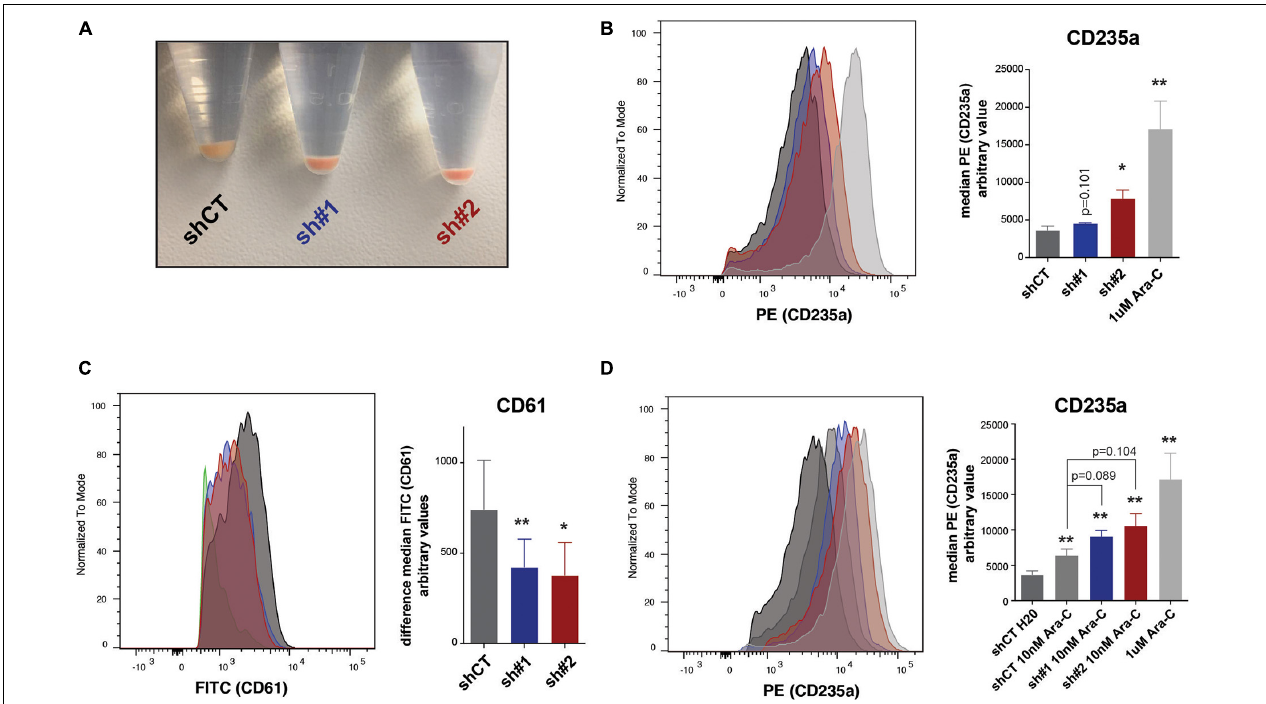
FIGURE 5 | (A) Picture of pelleted K562 infected with an empty short hairpin RNA (shRNA, shCT ) and two shRNAs against PHF19 ( sh #1 and sh#2 ) 5 days after puromycin selection. (B) CD235a marker levels measured by flow cytometry in shCT-, sh# 1-, sh#2-infected cells 4 days after puromycin selection and 1 µ M of Ara-C treatment in uninfected cells as a positive control. Left , representative plot of a single experiment. Right , bar plot of the mean of median cytometry values (shCt and sh#1, n = 4; sh#1 and 1 µ M of Ara-C, n = 3) + SEM. (C) CD61 marker levels measured by flow cytometry in shCT-, sh# 1-, and sh#2-infected cells 4 days after puromycin selection and treated with 1 nM phorbol myristate acetate (PMA) for 24 h. Left , representative plot of a single experiment. Right , bar plot of the mean of median cytometry values ( n = 3) + SEM. (D) CD235a marker levels measured by flow cytometry at 4 days in shCT-, sh# 1-, and sh#2-infected cells after puromycin selection and treated with 10 nM of Ara-C for 72 h, with 1 µ M of Ara-C treatment in uninfected cells as a positive control. Left , representative plot of a single experiment. Right , bar plot of the mean of median cytometry values (shCt, 10 nM Ara-C; sh#1, 10 nM Ara-C, n = 24; sh#1, 10 nM Ara-C, and 1 µ M of Ara-C, n = 3) + SEM. ∗ p < 0 . 05 ; ∗∗ p < 0 . 01